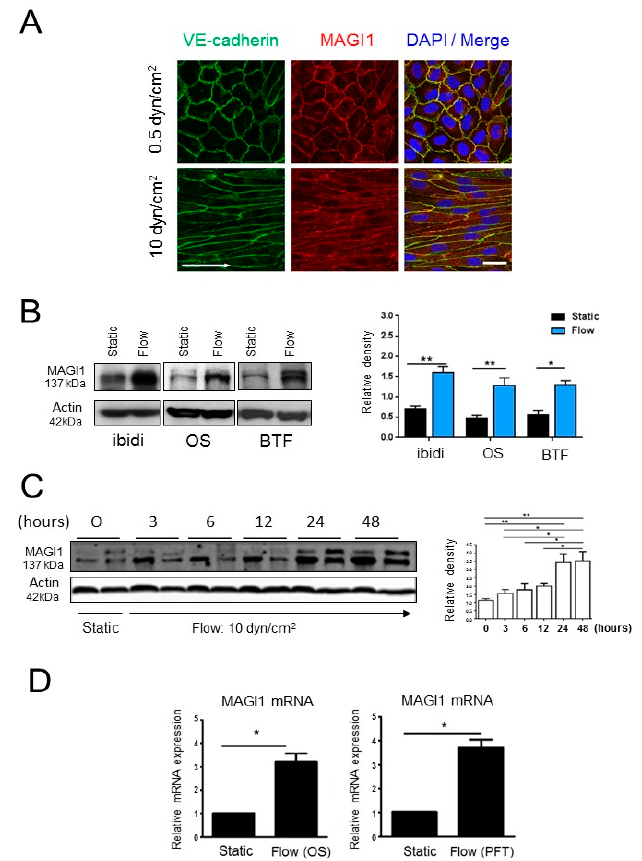
Figure 1. MAGI1 localizes at endothelial cell junctions and its expression is induced by shear stress. ( A ) Confocal laser microscopy of MAGI1 and VE-cadherin-stained HUVEC confluent cultures under static conditions (0.5 dyn / cm 2 ) and after enhanced fluid shear stress of 10 dyn / cm 2 for 24 h using the BioTechFlow system (BTF). MAGI1 co-localizes with VE-cadherin under static and flow conditions. Arrows: direction of flow. N = 5. Scale bar = 25 µ m. ( B ) HUVEC cultured under static conditions